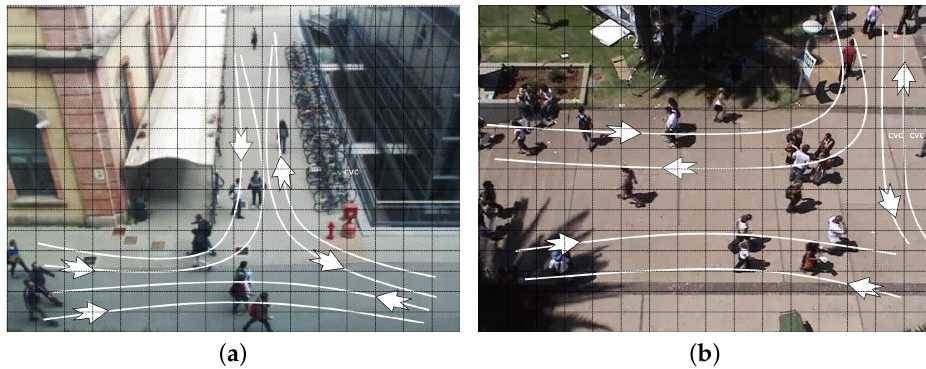
Figure 11. Two typical working scenarios for our application (( a ) home-made, ( b ) taken from [49]), highlighting six main pedestrian flows which can be used to optimize the divide-and-conquer procedure represented by the grid overlapping both pictures.